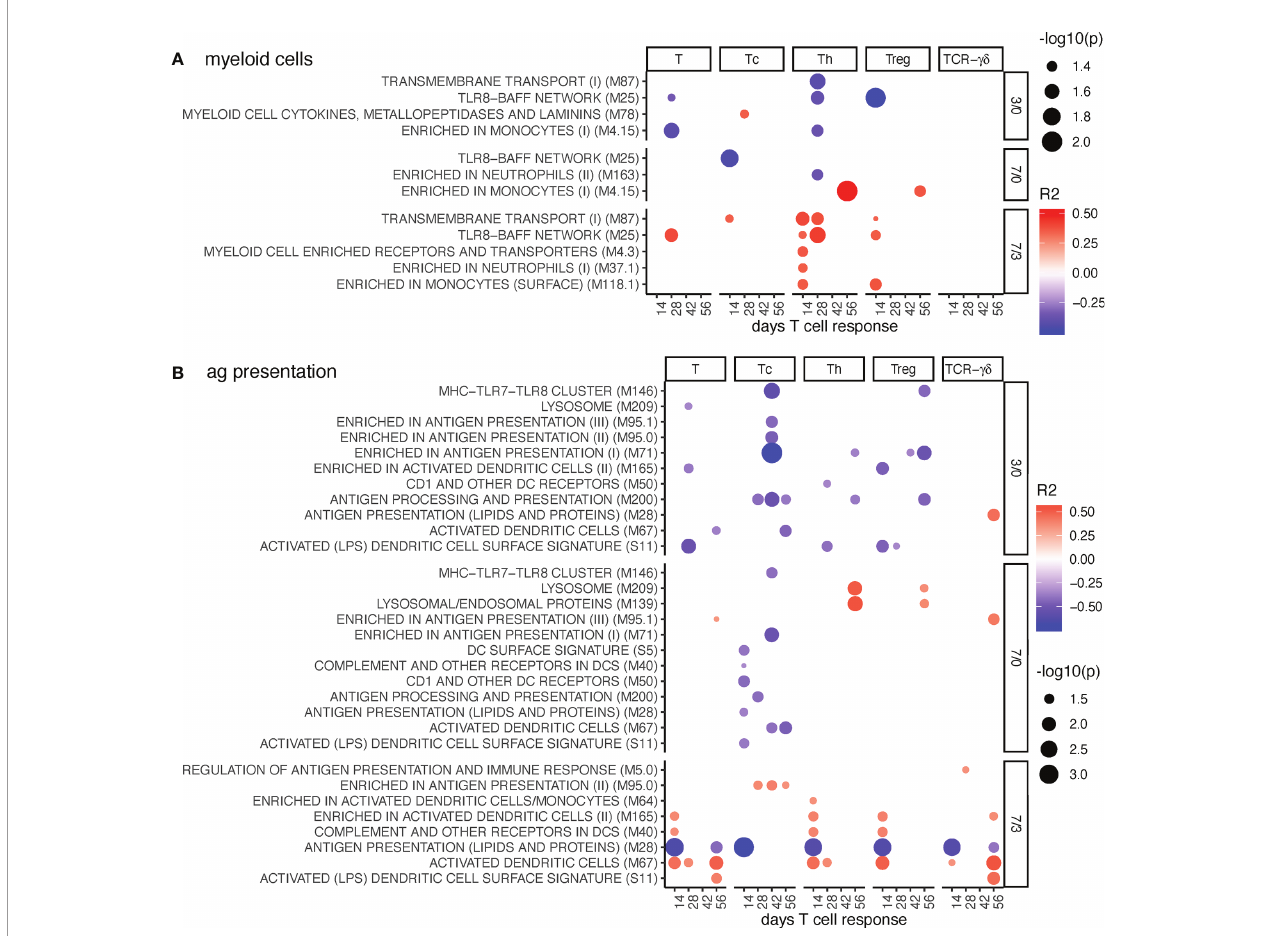
FIGURE 4 | Myeloid cell and antigen presentation BTM correlating with T-cell priming. Time-dependent single-sample enrichment scores for BTM were correlated with the proliferative recall response of total CD3 + T cells, Tc, Th, and TCR- gd T-cells measured at 14, 28, 42, and 56 days after LP or HP PRRSV-2 infection [x-axis, data from (15)]. R squared correlation coef fi cients for the BTM changes from D3/0, D7/0, and D7/3 are indicated by the color gradient (red for positive values, blue for negative values). Increased circle sizes indicate smaller p values (cutoff < 0.05). (A) shows myeloid cell BTM and (B) antigen presentation BTM families